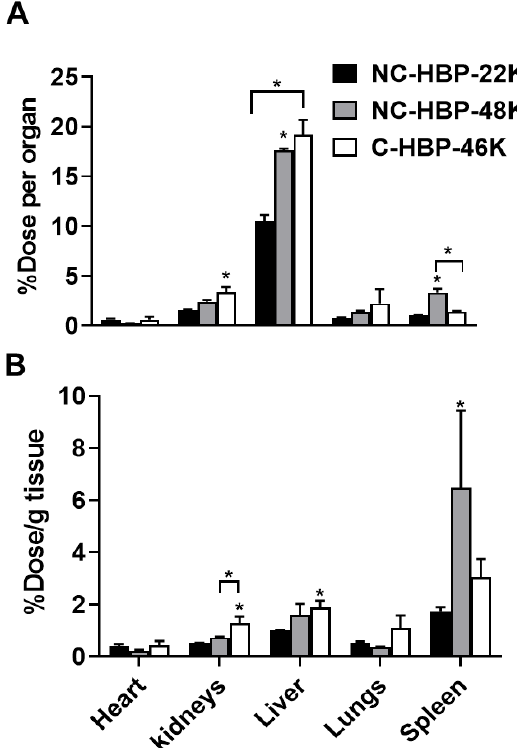
Figure 6. Organ biodistribution of 89 Zr-labelled HBPs after intravenous administration in rats measured by gamma counting of extracted organs after termination. Panel ( A ) Percent of 89 Zr dose recovered per organ. Panel ( B ) Percent of 89 Zr recovered per gram of tissue. ( n = 3 rats for all groups except NC-HBP-48K where n = 2 rats and data are represented as mean ± range). Statistical significance was conducted using one-way ANOVA followed by Tukey’s test. * indicates p < 0.05 compared with NC-HBP-22K.